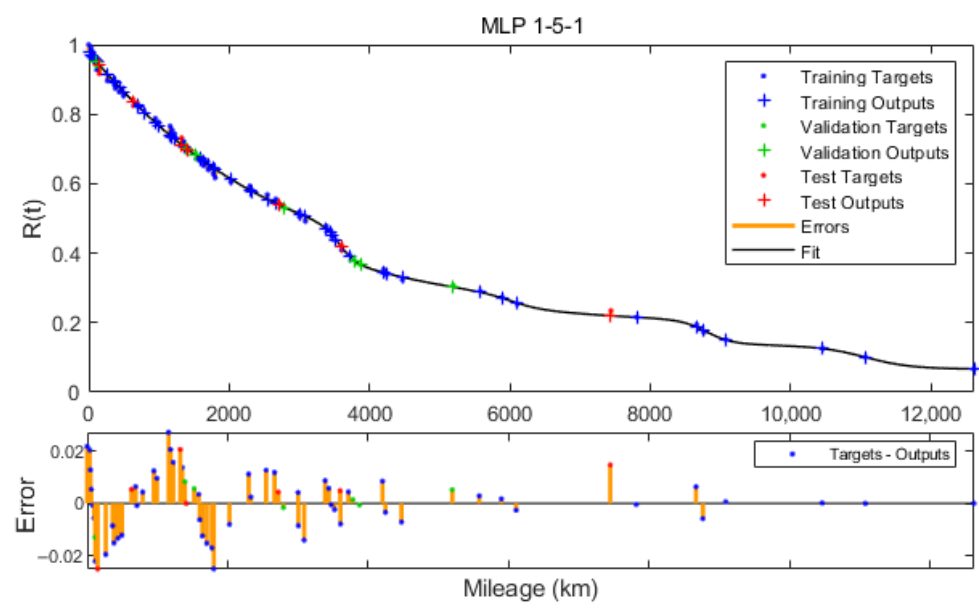
Figure A4. Reliability function approximated by MLP 1-5-1.